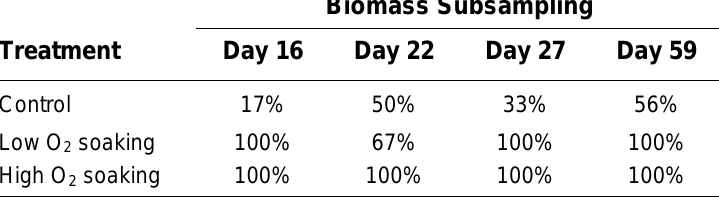
Percent of Black Willow ( S. nigra ) Cuttings with Observed ARF During Random Biomass Subsampling on Days 16, 22, and